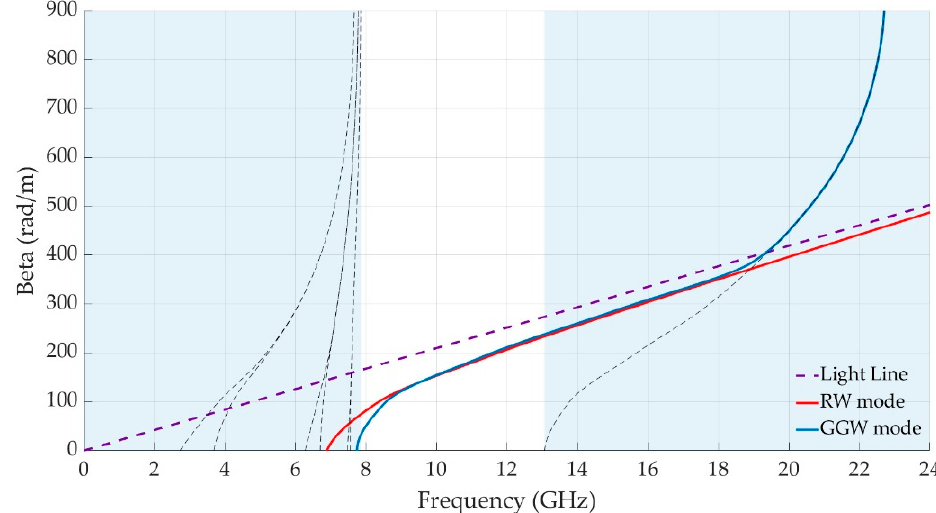
Figure 2. Groove gap waveguide dispersion diagrams. Solid blue curve is the only mode propagating in the stopband. Black Dashed curves are the modes propagating outside the stopband.